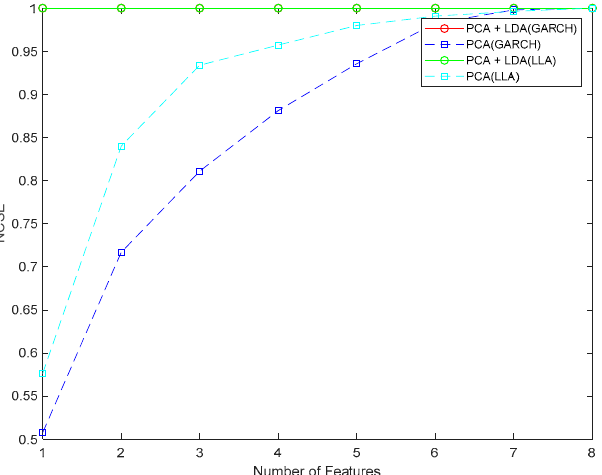
Figure 8. Normalized cumulative summation of eigenvalues of training data for the GARCH and LLA methods for different PCA and PCA + LDA methods (two-classes).